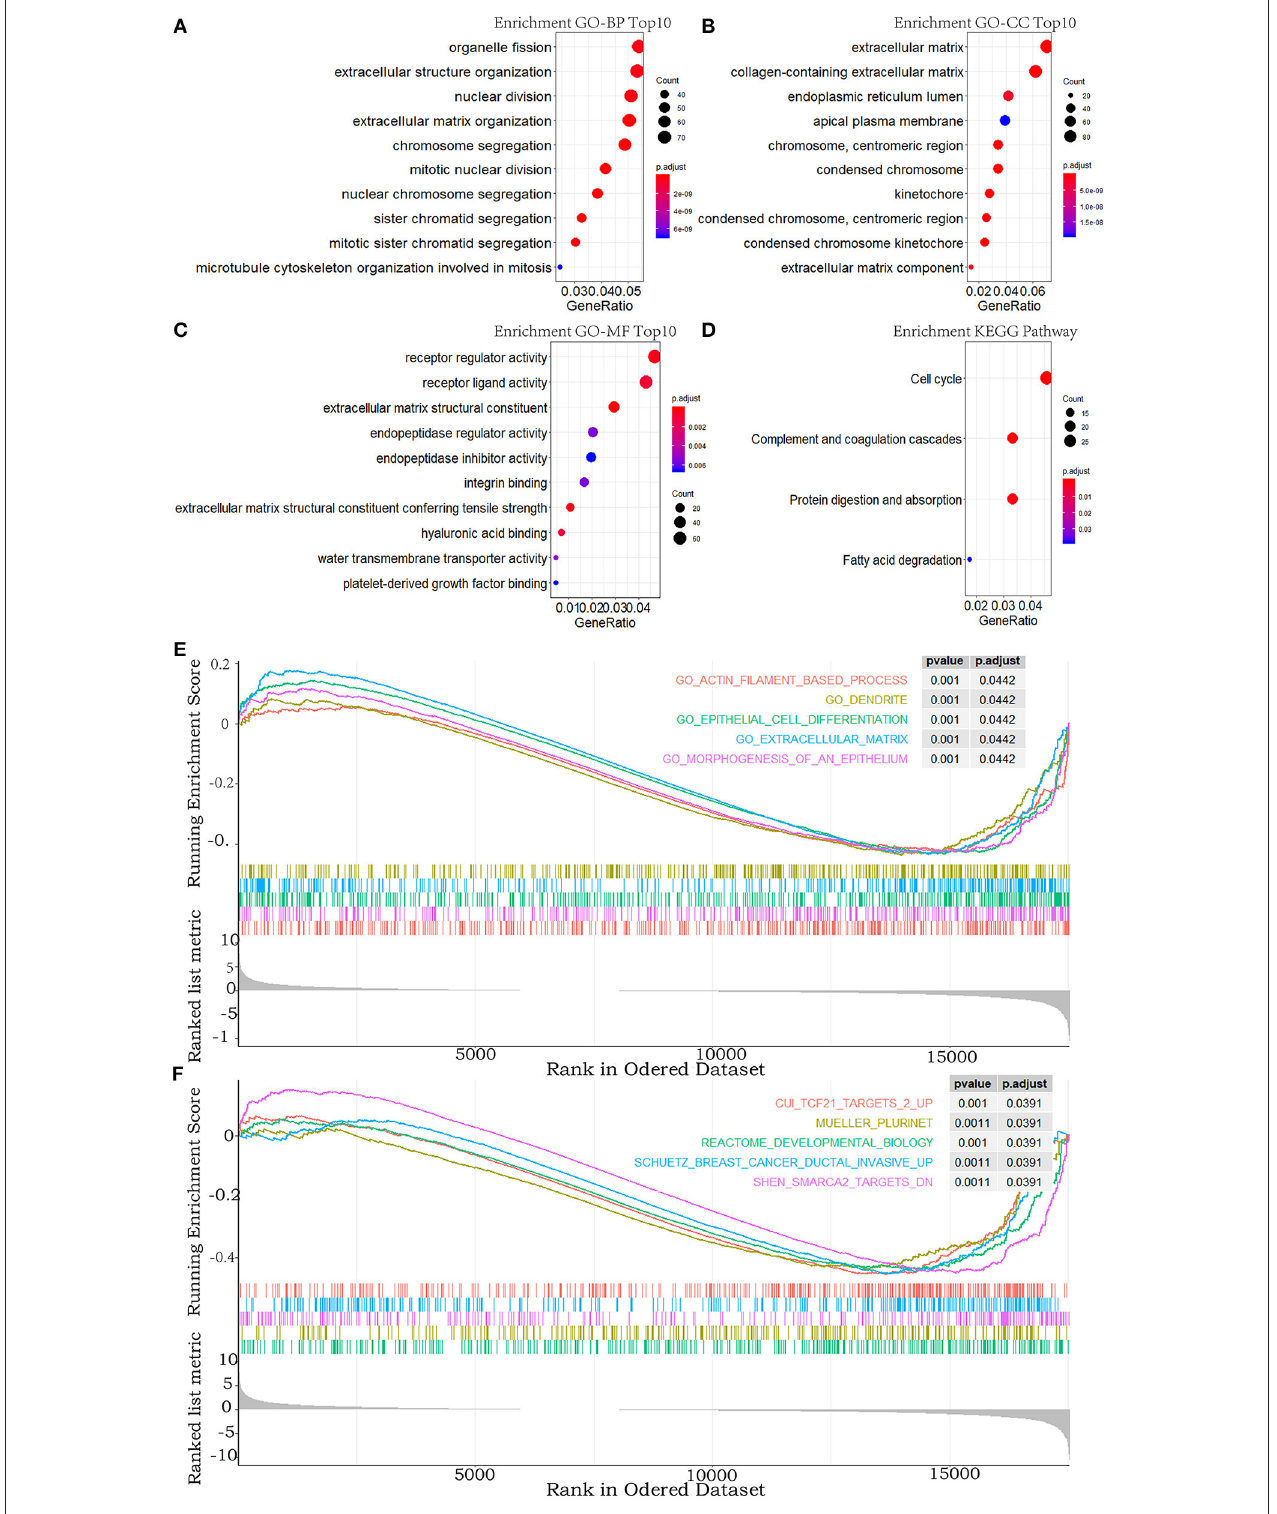
FIGURE 2 | GO, KEGG pathway, and GSEA enrichment analyses. (A–C) Top 10 enriched terms in GO-BP, GO-CC, and GO-MF. (D) The significant terms in the KEGG pathway. (E,F) TOP 5 enriched terms of GSEA in the c5.all.v6.2.entrez.gmt gene sets and the c2.all.v6.2.entrez.gmt gene sets. P- value adjusted by FDR < 0.05.